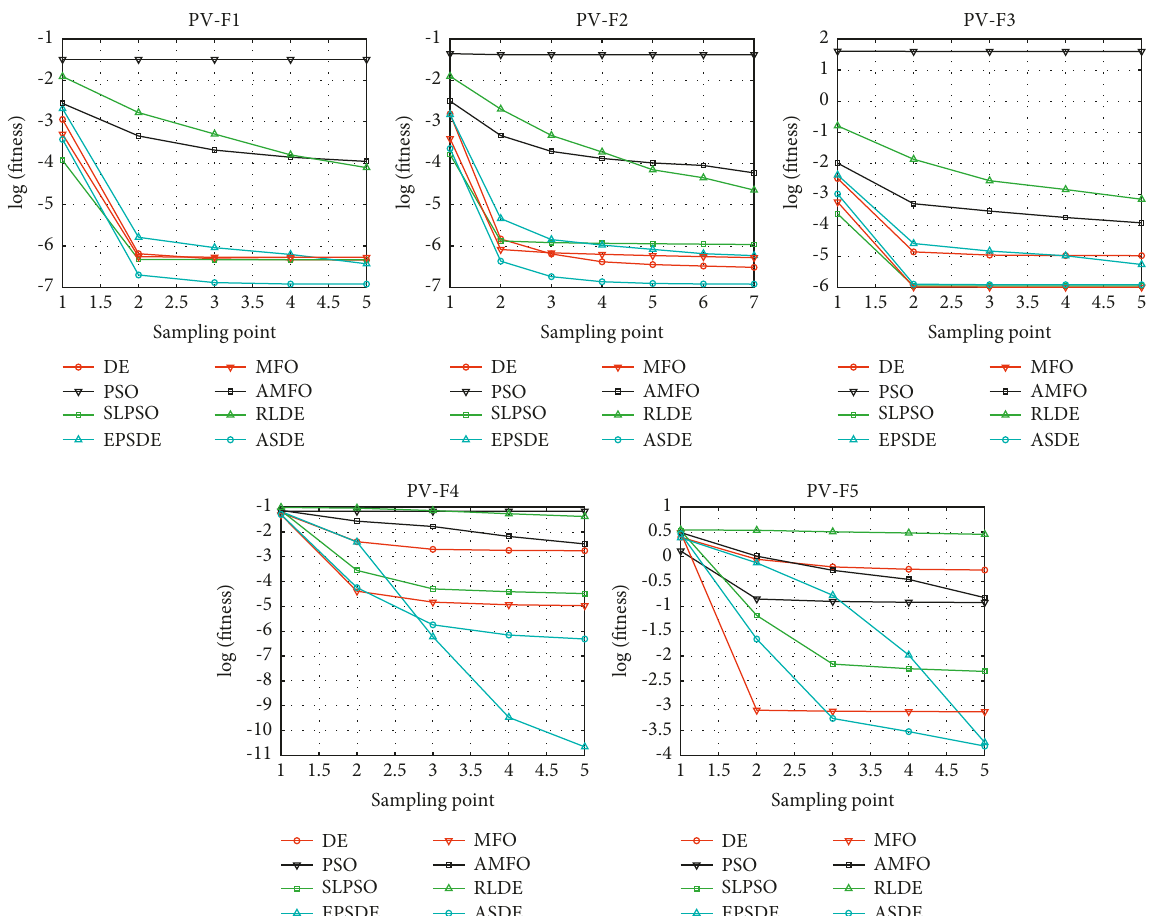
Figure 6: Convergence performance of the eight compared algorithms on 5 PV